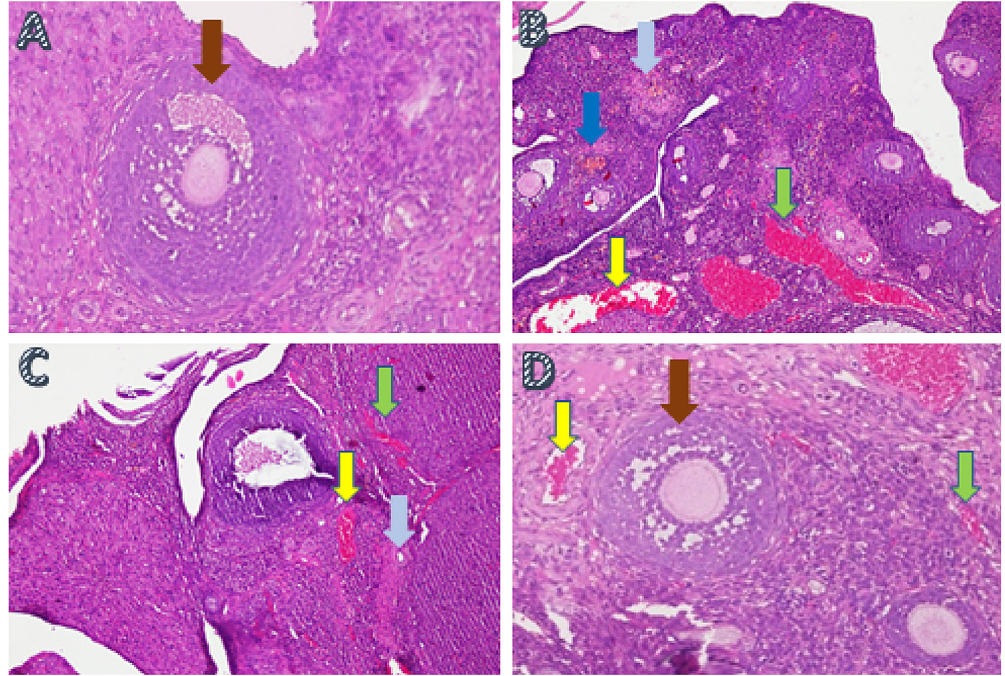
Figure 3. The ovarian tissue regeneration through the method of histopathology anatomy with hematoxylin and eosin (H&E) staining in ovarian rat tissue in a few treatments. A. Fertile female, negative control group (T (cid:1) ): shows growing follicle ( ); B. Infertile female, positive control group (T+): congestion of the ovary ( ) and widely hemorrhagic ( ), also visible hemosiderin ( ) due to blood cell hemolysis (brownish-yellow color) with fibrin deposition ( ), indicating that chronic congestive has occurred; C. Infertile female with 30% honey v/v group (T1): ovarydoesnotregenerate,congestionappearsalongthehemosiderinexpressionandremainswidelyhemorrhagic; D. Infertile female with 50% honey v/v group (T2): ovaries begin to regenerate, making it appear intact; hemorrhage and congestion still appears in some areas with growing